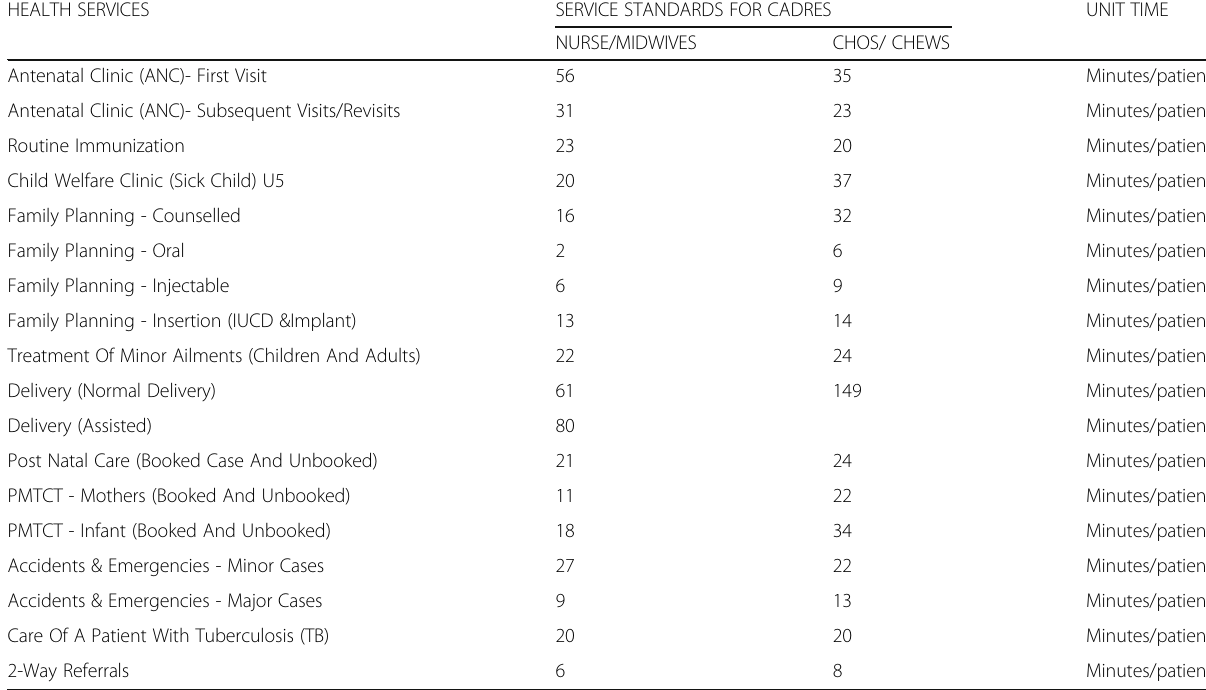
Table 2 Validated health service acitvities and service standards for primary healthcare centre HEALTH SERVICES